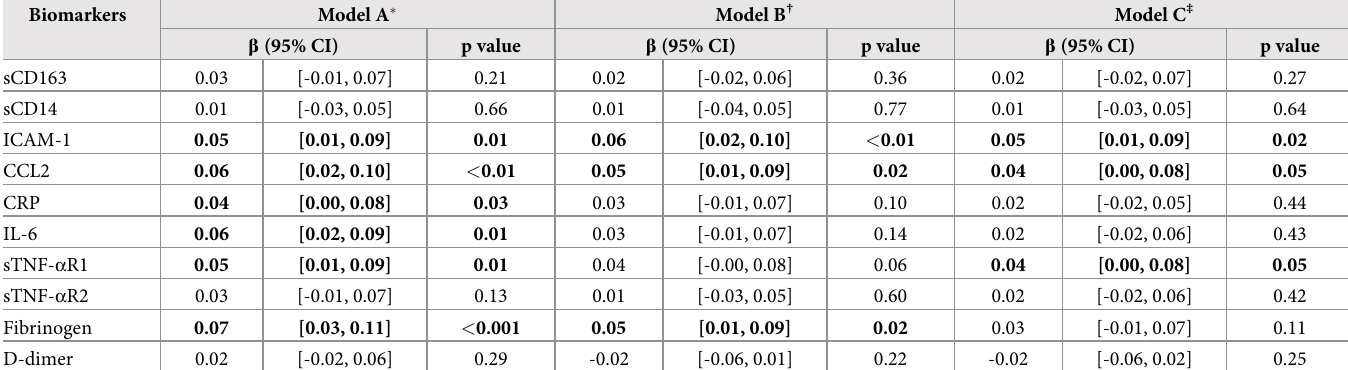
Table 4. Associations between inflammatory biomarkers and intima media thickness at the bifurcation of the right common carotid artery (bifurcation-IMT) (N = 672).